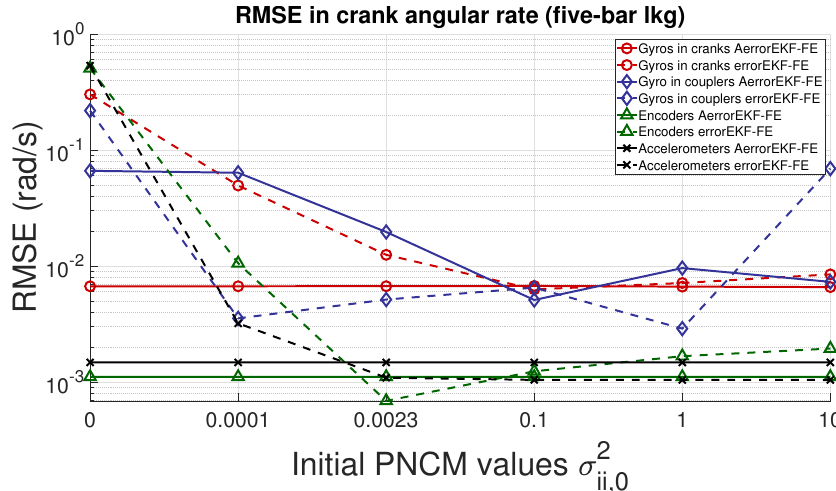
Figure 12. RMSE of the norm of the two crank angular rates (velocity) provided by the observers for the five-bar linkage.